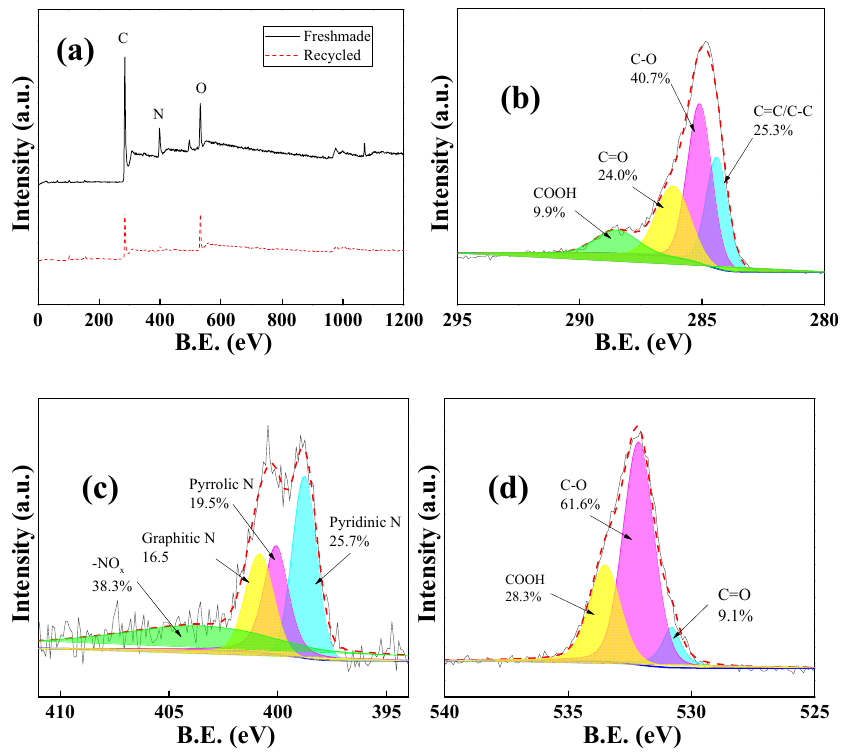
Figure 8. ( a ) Wide-scan XPS spectra, ( b ) C 1s, ( c ) N 1s, ( d ) O 1s spectra of used N-PPB600.